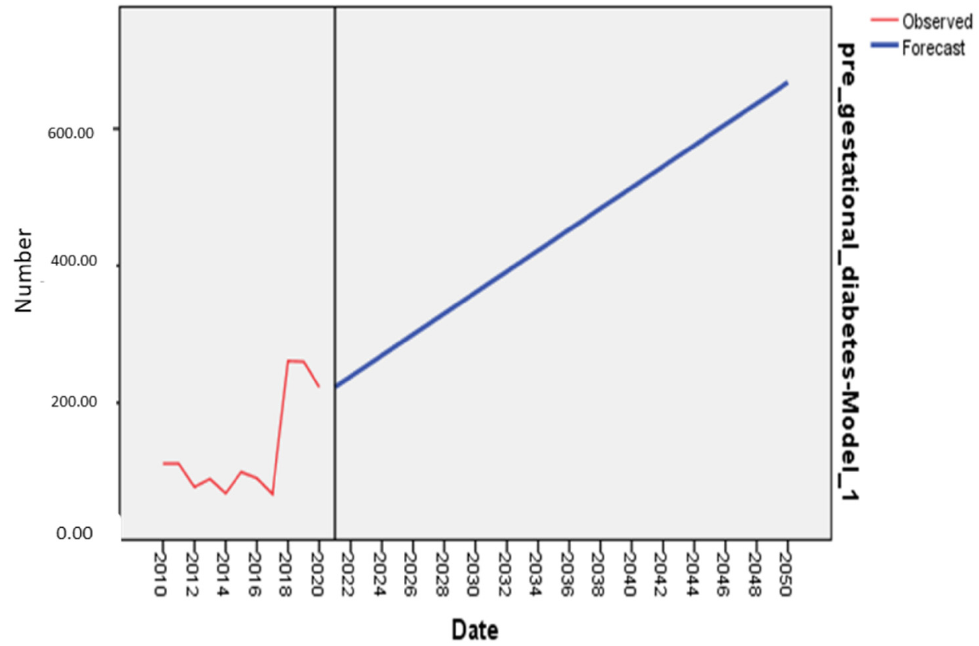
Figure 5. The forecast of the total number of women with pre-gestational diabetes in 2030 and 2050.